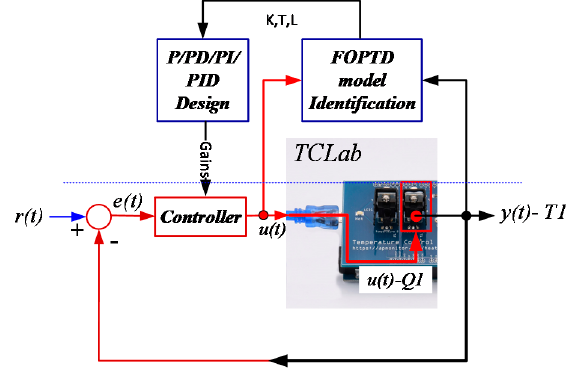
Figure 5. TCLab system identification and controller tuning approach.